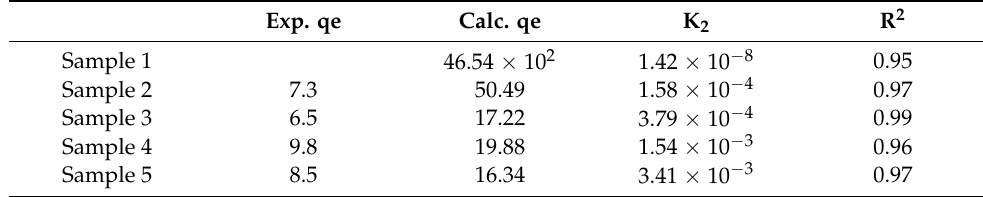
Table 2. Pseudo-second order parameters.